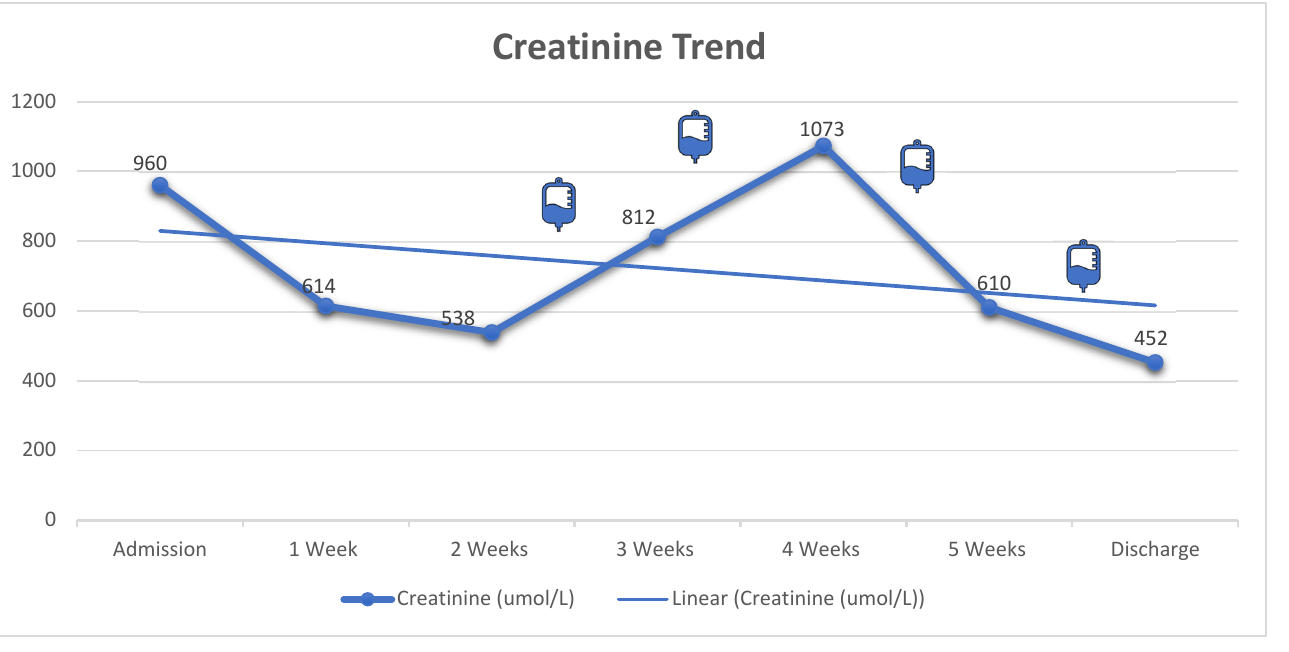
Figure 3. Trend of creatinine level during hospital course. The infusion bag icons correlate with the time of each rituximab dose. Rituximab resulted in a sustained improvement of all the hematological parameters (Figures 1 and 2), but there was no improvement in kidney function.